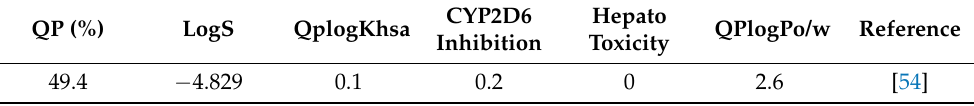
CYP2D6 Inhibition